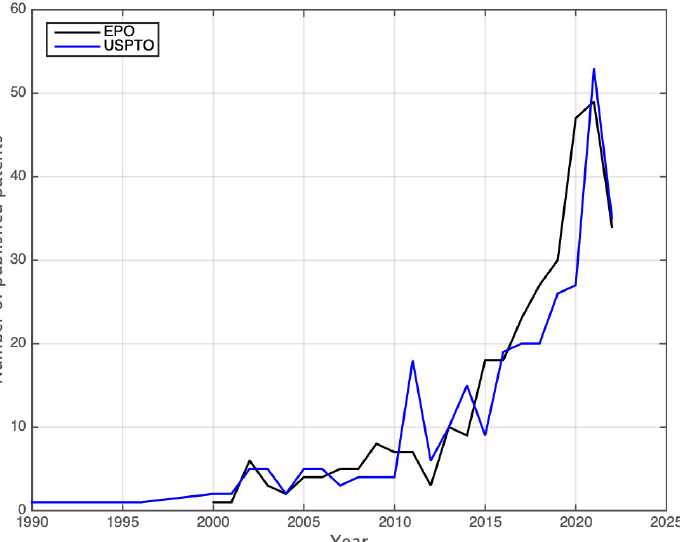
Figure 7. Number of published patent applications reported in the European Patent Office (EPO) and the United States Patent and Trademark Office (USPTO) per year. Data obtained on the respec- tive databases, by sorting the keyword “laser induced forward transfer” as a whole string on 11 November 2022.